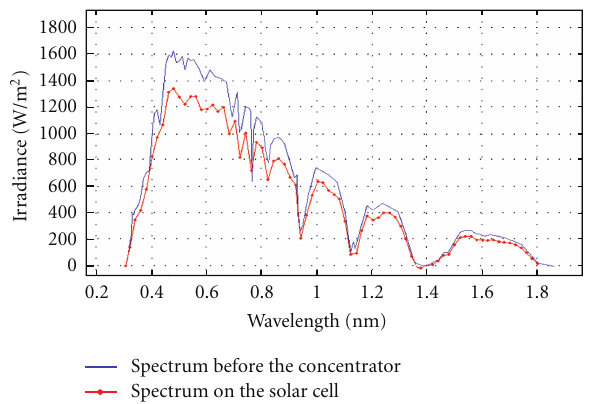
Figure 9: Spectral transmission power before and after the concen- trator.